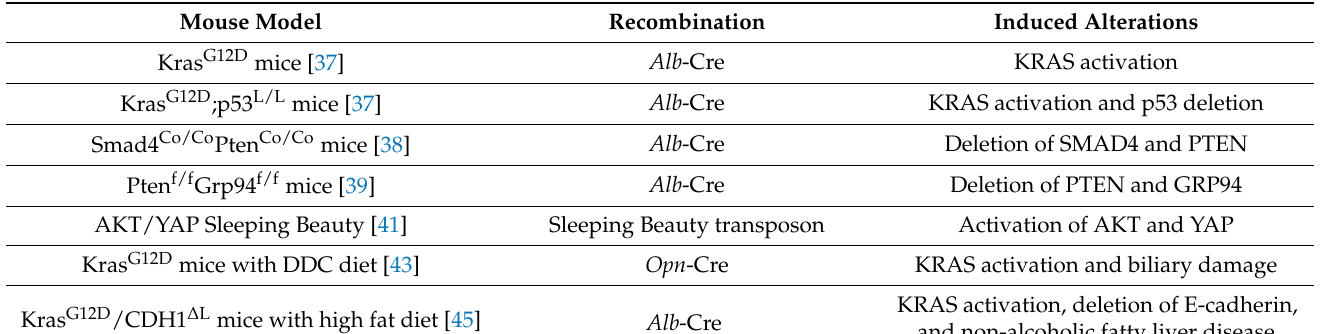
Table 1. Selected genetically engineered CCA mouse